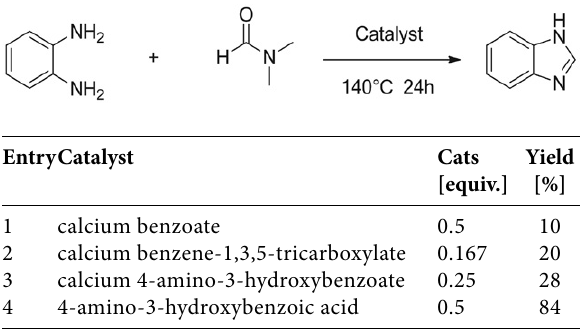
Table 3. The cyclization of o -phenylenediamine and DMF catalyzed by various calcium salts and 4-amino-3-hydroxybenzoic acid